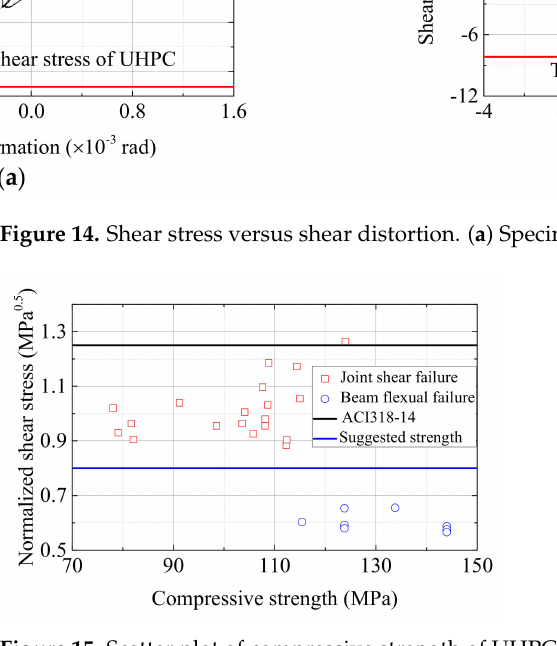
Figure 15. Scatter plot of compressive strength of UHPC versus normalized shear